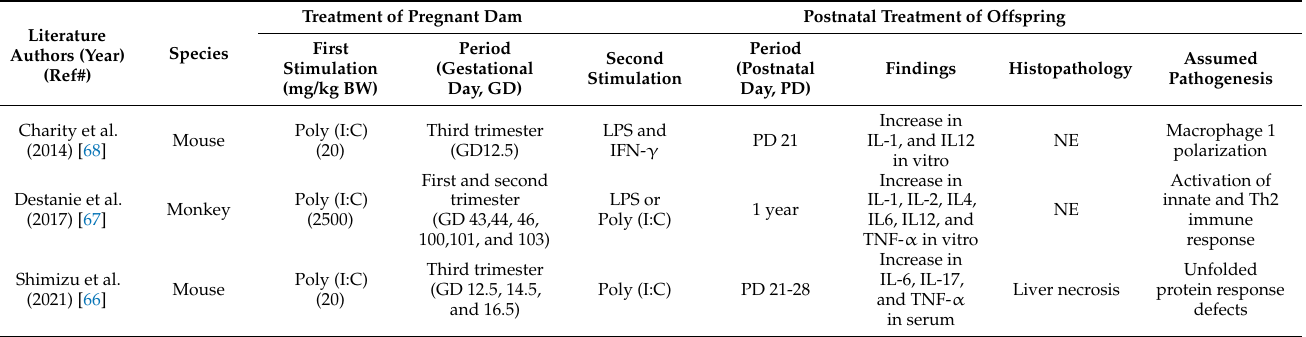
Table 1. Association between MIA caused by poly (I:C) and immune disorders caused by postnatal inflammatory